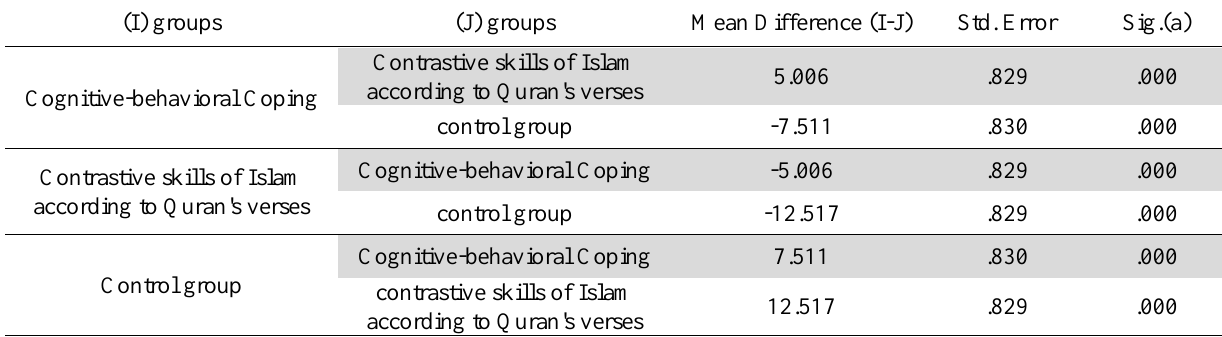
The summary of anxiety in post-test stage